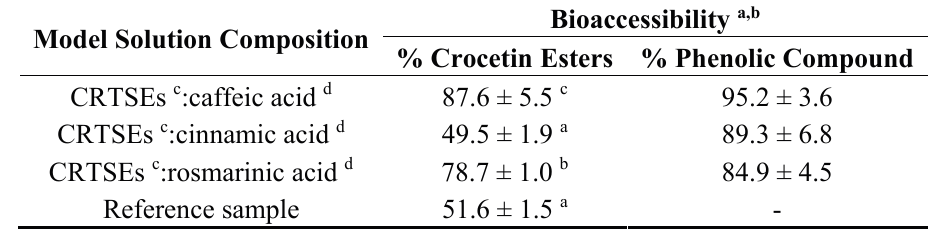
Table 2. The % bioaccessibility of CRTSEs and of selected phenolic compounds upon simulated gastrointestinal conditions.